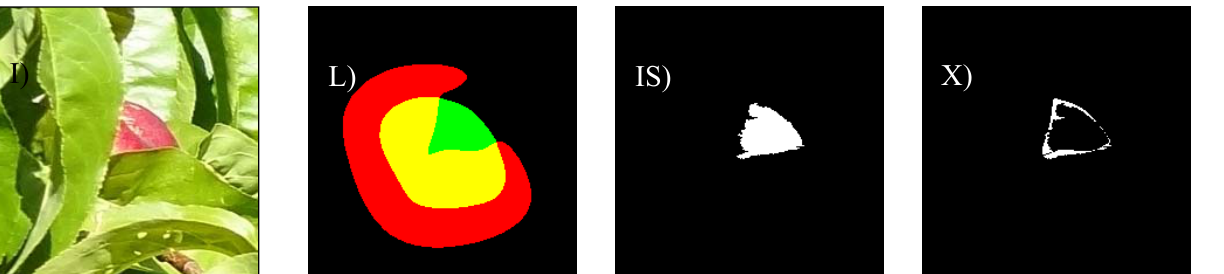
Figure 14. Sample bright illumination image with occlusion of